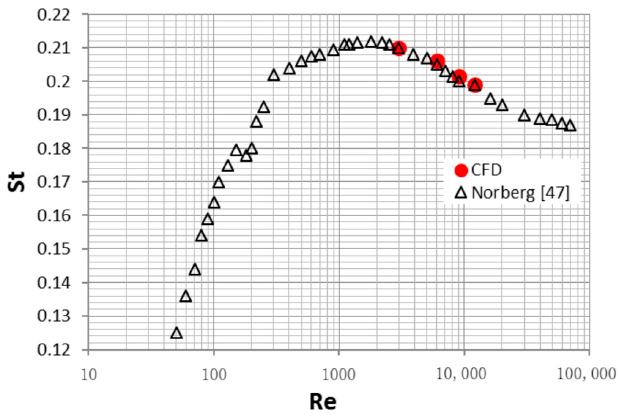
Figure 7. Variation of Strouhal number, St, with Reynolds number, Re. Experimental data extracted from Norberg [47].